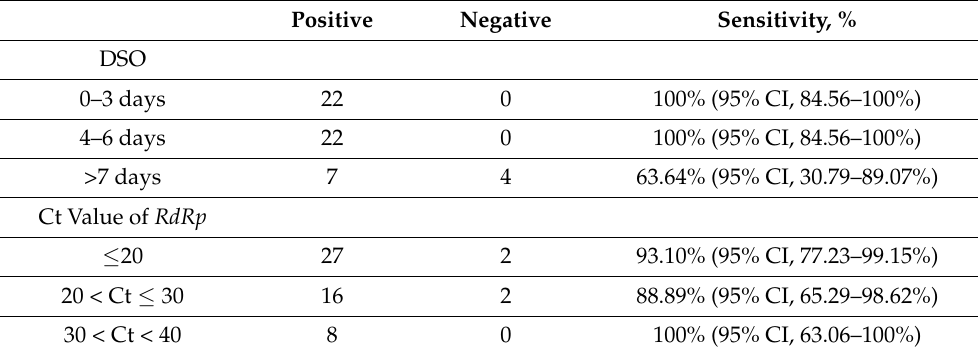
Table 4. Sensitivities of the STANDARD Q COVID/FLU Ag Combo for detection of SARS-CoV-2 according to days after symptom onset (DSO) and the Ct value of RdRp to the collection of samples.